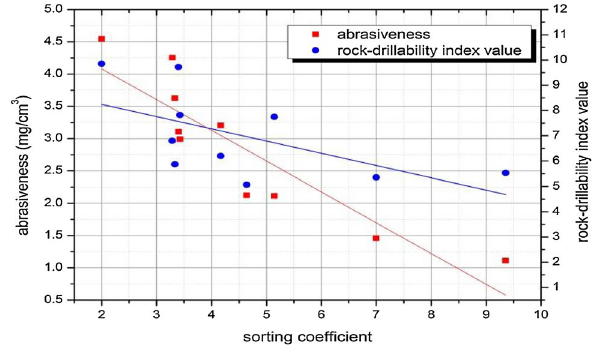
Fig. 7 The influence law of sorting coefficient on rock drillability and